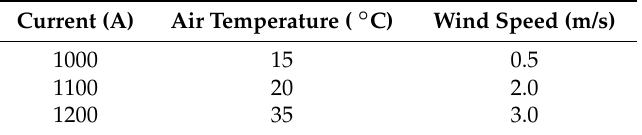
Table 2. Parameters of the additional extrapolation verification tests (3 × 3 × 3 = 27